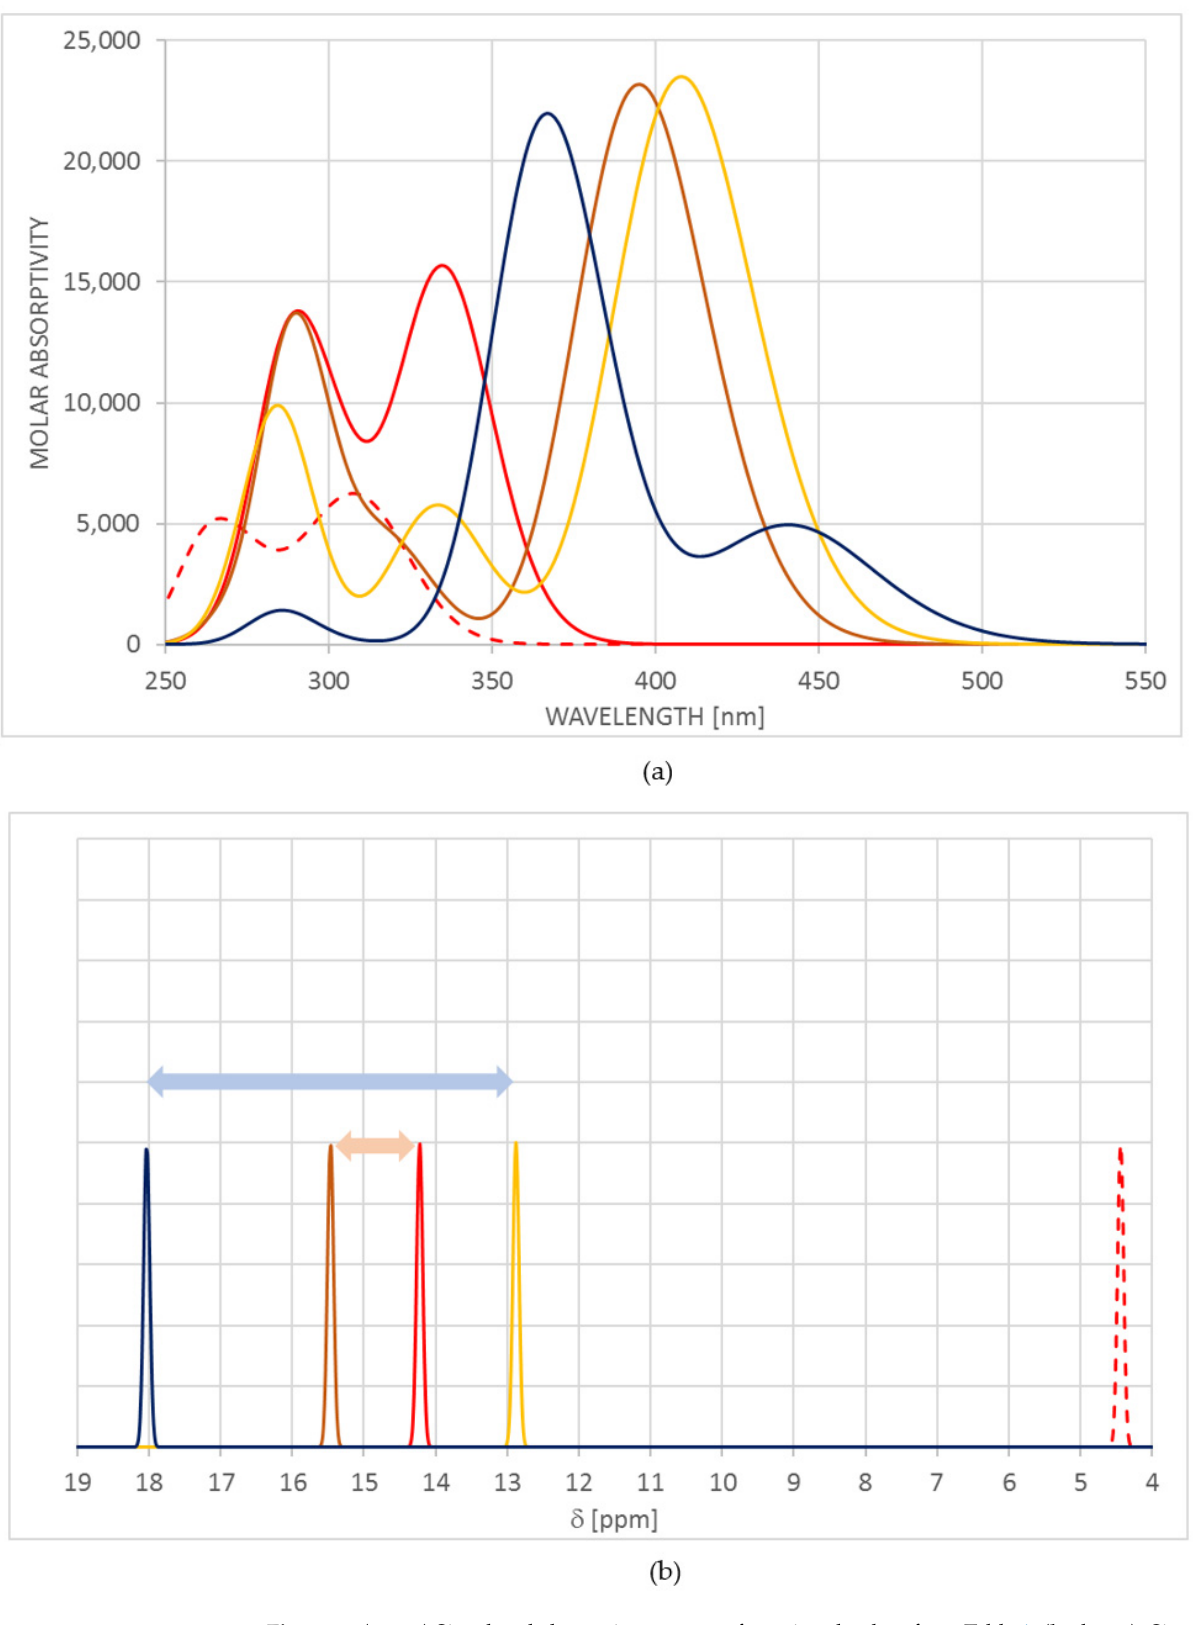
Figure 3. ( a , top) Simulated absorption spectra of 1 , using the data from Table 1; ( b , down). Simulated 1 H NMR chemical shifts of the tautomeric proton. The tautomeric form is given as follows: E —red solid line, K E —brown solid line, K K —yellow solid line, K —blue solid line, and E cis —red